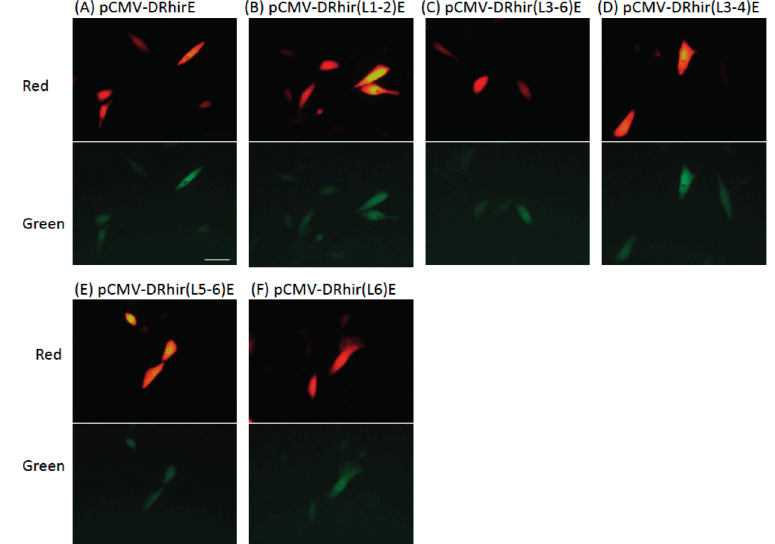
Figure 5. The truncated RhPV 5 ′ UTR IRES element fragments displayed internal translational activity in mammalian cells. CHO cells (5 × 10 4 cells per well, seeded in a 24-well plate) were transfected with pCMV-DRhirE ( A ); pCMV-DRhir(L1-2)E ( B ); pCMV-DRhir(L3-6)E ( C ); pCMV-DRhir(L3-4)E ( D ); pCMV-DRhir(L5-6)E ( E ) or pCMV-DRhir(L6)E ( F ) and observed at two days after transfection under fluorescence microscopy. Pictures were taken in the same field using a conventional rhodamine channel (Red) with a 510/560-nm filter set and a FITC channel (Green) with a 450/490-nm filter set. All pictures were taken with the same exposure time (900 and 400 ms for EGFP and DsRed, respectively). Scale bar is 50 μ